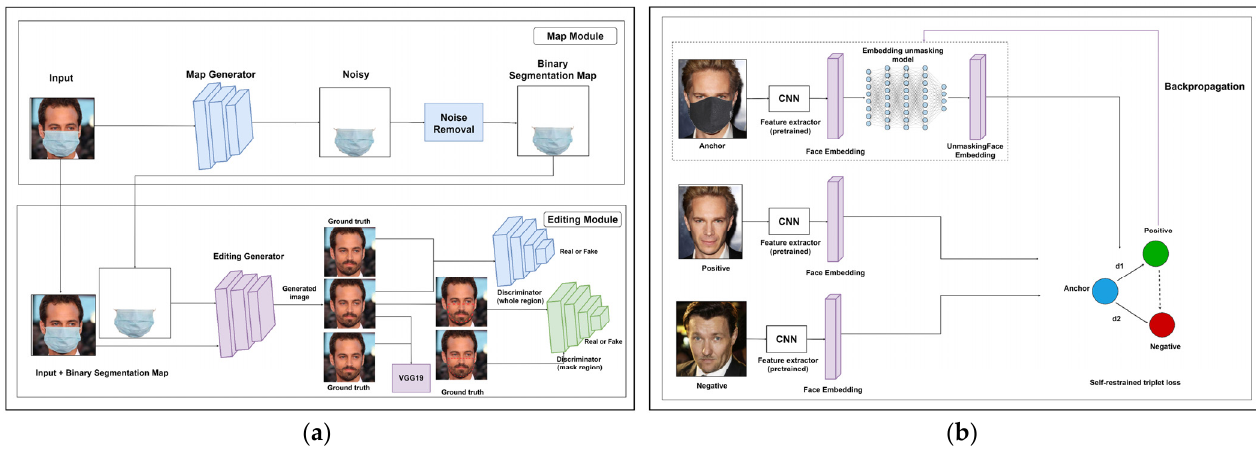
Figure 3. The general approach of ( a ) GAN-based network with two discriminators and ( b ) EUM model. ( a ) GAN-based face unmasking and restoration [29]. ( b ) EUM-based face unmasking [123].